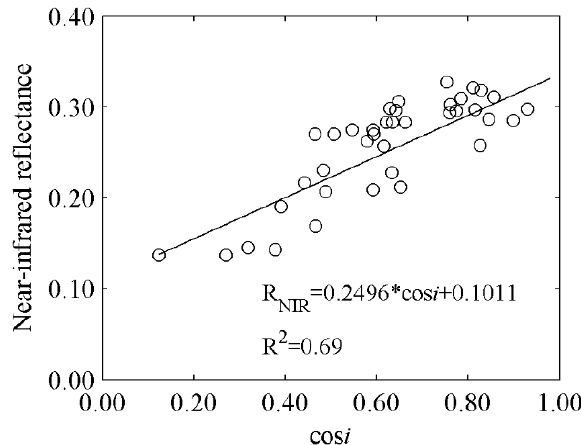
Figure 5. Observed impact of cosi (local terrain orientation with respect to the sun) on Landsat-8 reflectance in the nIR band. The linear regression line between near-infrared band reflectance and cosi ( n = 42) is also